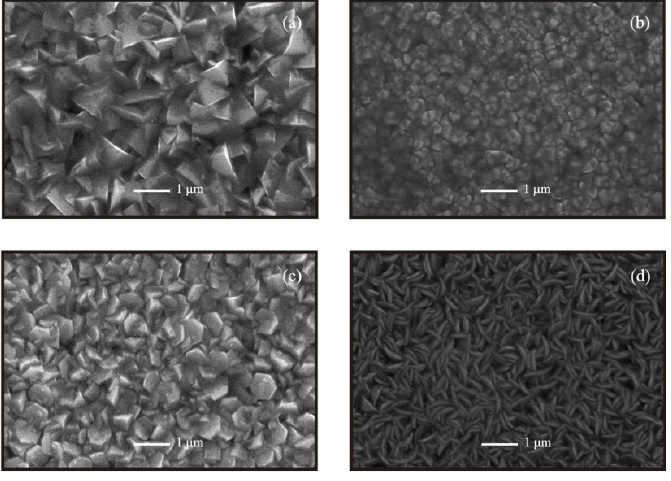
Figure 4. Scanning electron microscopy (SEM) images of ZnO:Al thin films deposited from starting solutions prepared from unmilled and milled precursors at different times: ( a ) unmilled; ( b ) 15 min; ( c ) 35 min; and ( d ) 60 min.